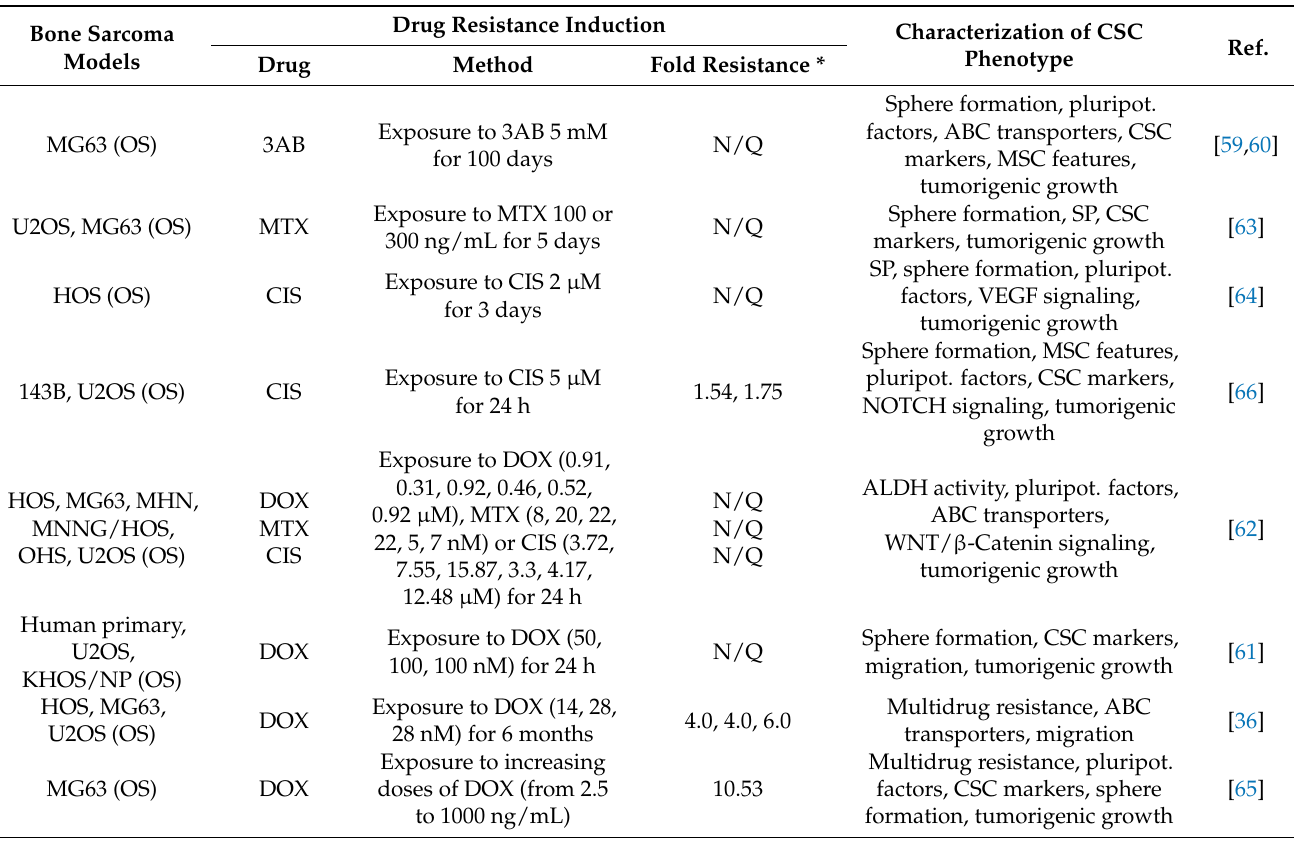
Table 2. Enrichment of CSCs after drug